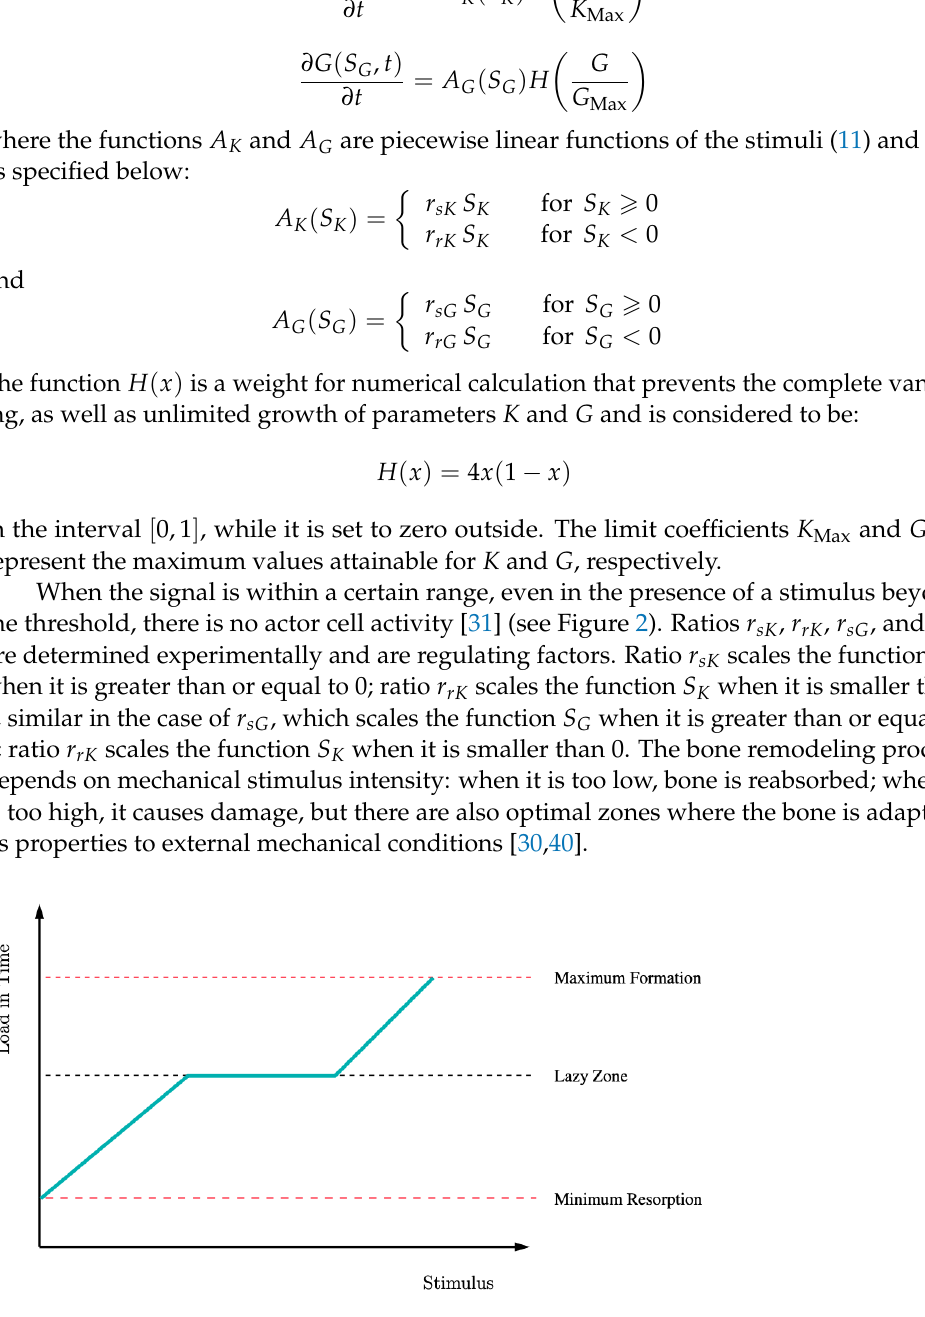
Figure 2. Effect of the load on stimulus. Low mechanical loading results in bone resorption: it is the resorption stimulus zone; subsequently, in the lazy zone (black dotted line), there is no change in bone; with a sufficiently high load, the formation of the stimulus zone occurs in a certain range highlighted with red dotted